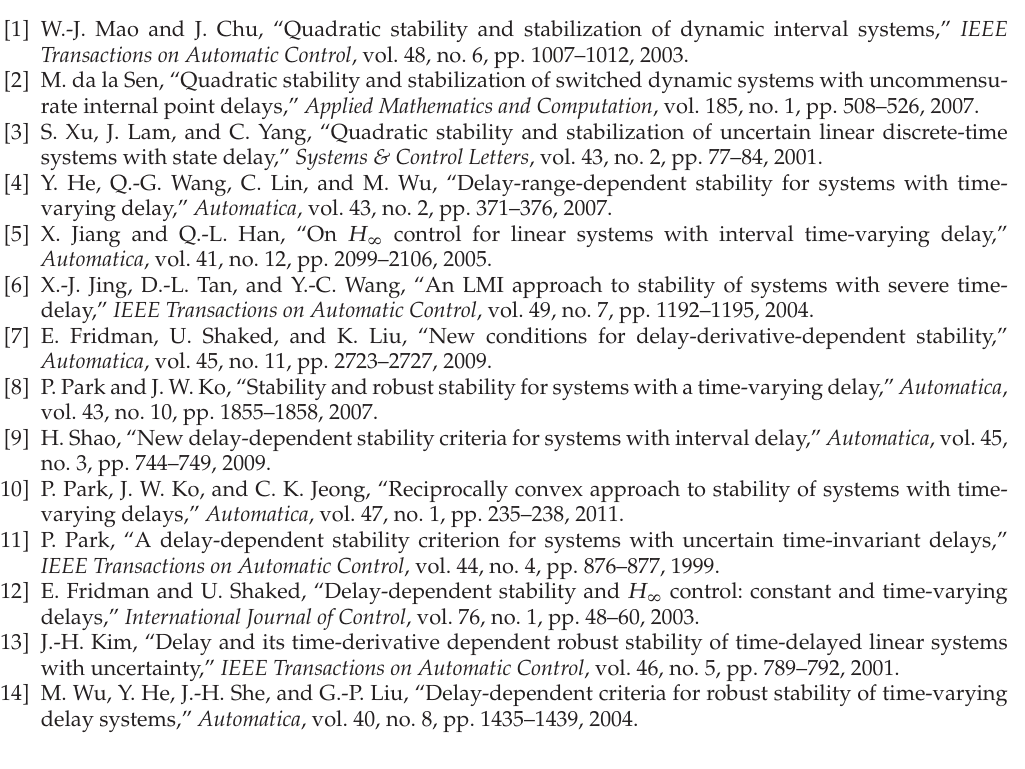
2 for various d 1